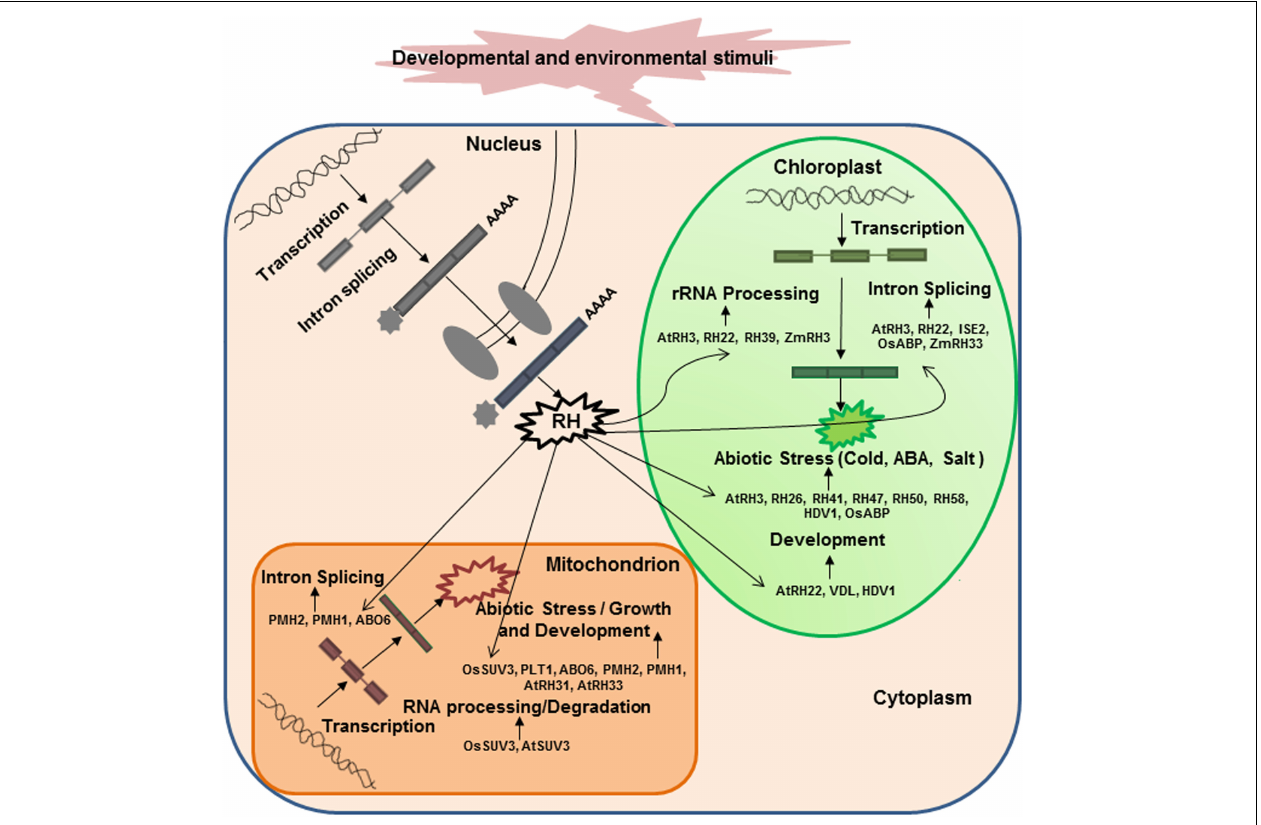
FIGURE 2 | Cellular functions of diverse DEAD-box RHs involved in RNA metabolism in chloroplasts or mitochondria. A variety of nucleus-encoded RHs are targeted to chloroplasts or mitochondria and play essential roles in RNA processing, intron splicing, and translation, crucial for organellar biogenesis, function, and stress responses. Examples of the experimentally verified DEAD-box RHs that play unique roles in chloroplasts and mitochondria are shown in parenthesis. The functions and cellular roles of each RH are described in Table 1